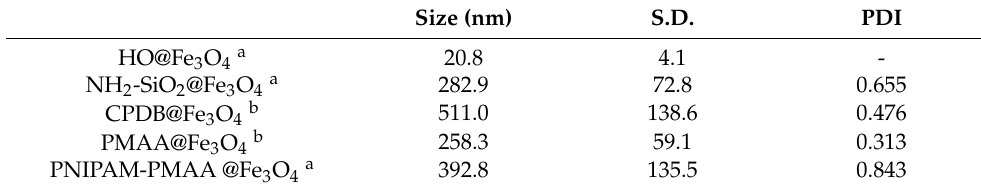
Figure 2. Distribution pattern of the hydrodynamic diameters of ( a ) HO@Fe 3 O 4, NH 2 -SiO 2 @Fe 3 O 4 and PNIPAM-PMAA @Fe 3 O 4 in dd-H 2 O and ( b ) CPDB@Fe 3 O 4, and PMAA@Fe 3 O 4 in dimethyl formaldehyde (DMF). Table 1. The analysis of dynamic light scattering (DLS) for particles.